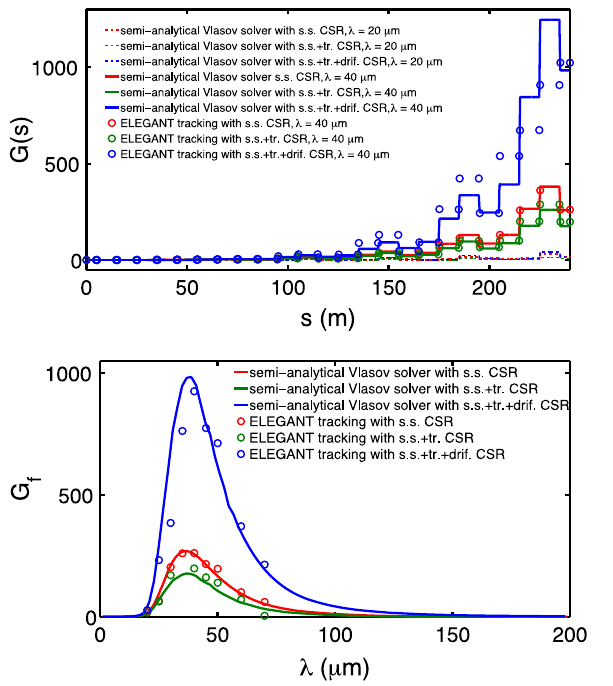
FIG. 2. (Top) Gain functions G ð s Þ as a function of s , where the dashed lines are for λ ¼ 20 μ m and solid lines for λ ¼ 40 μ m.